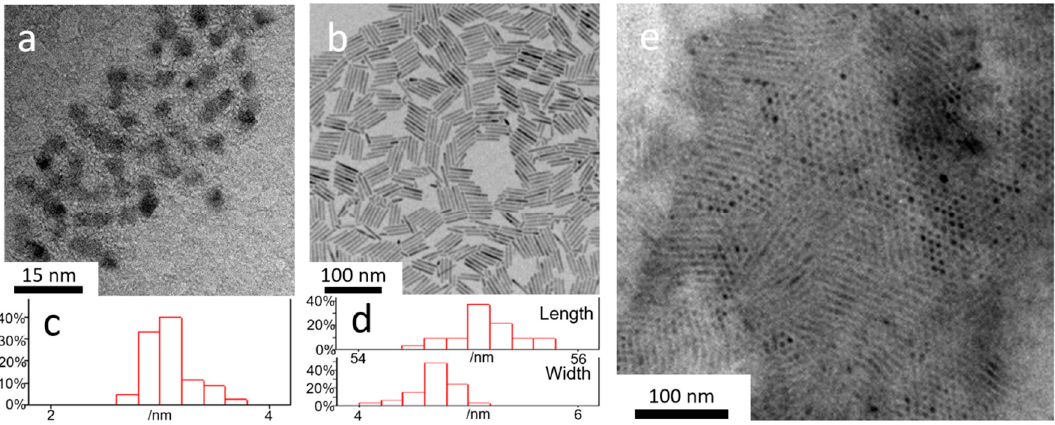
Figure 1. TEM images of ( a ) CdSe quantum dots (QDs); ( b ) CdSe / CdS quantum rods (QRs) and ( e ) CdSe / CdS / ZnS QRs-in-matrix assembly (QRAs) and the size distribution of the ( c ) QDs and ( d ) QRs.